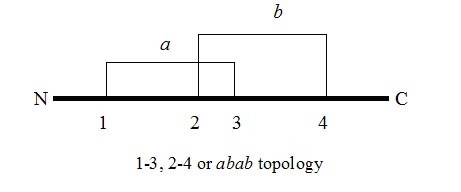
Nomenclature for disulfide topologies. Disulfides can be labeled by the sequence positions, or simply by the sequential number of the cysteine residues they connect (1–3, 2–4 topology). Alternatively, it is customary to alphabetically label the disulfide bridges, and and to assign bridge label to the cysteines, starting from the N terminus (abab topology).